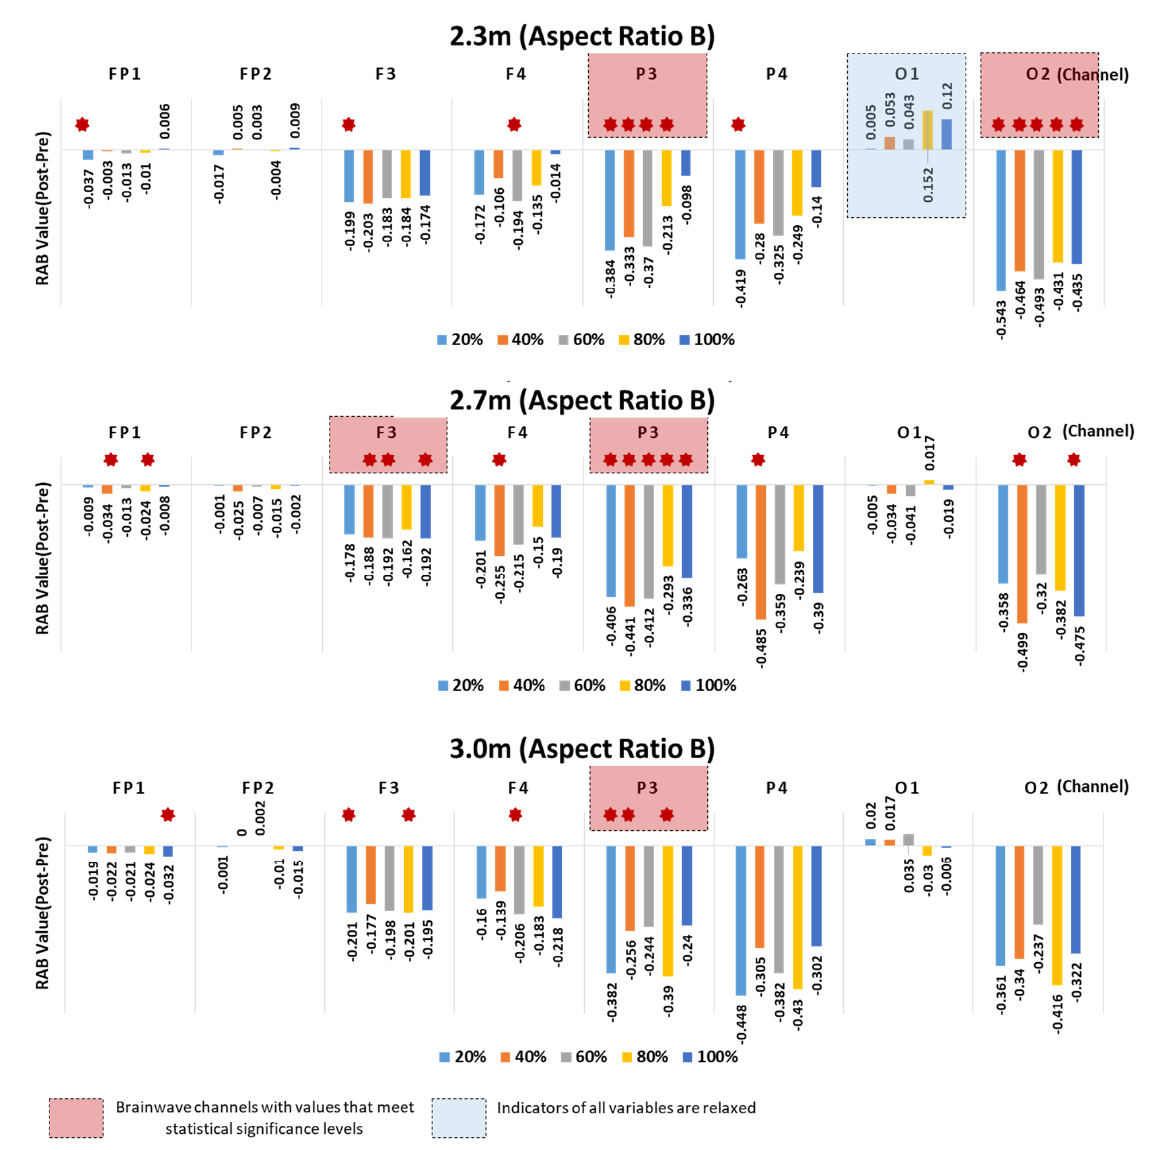
Figure 11. Aspect Ratio B—results of RAB indicator analysis for window ratio by ceiling height type.